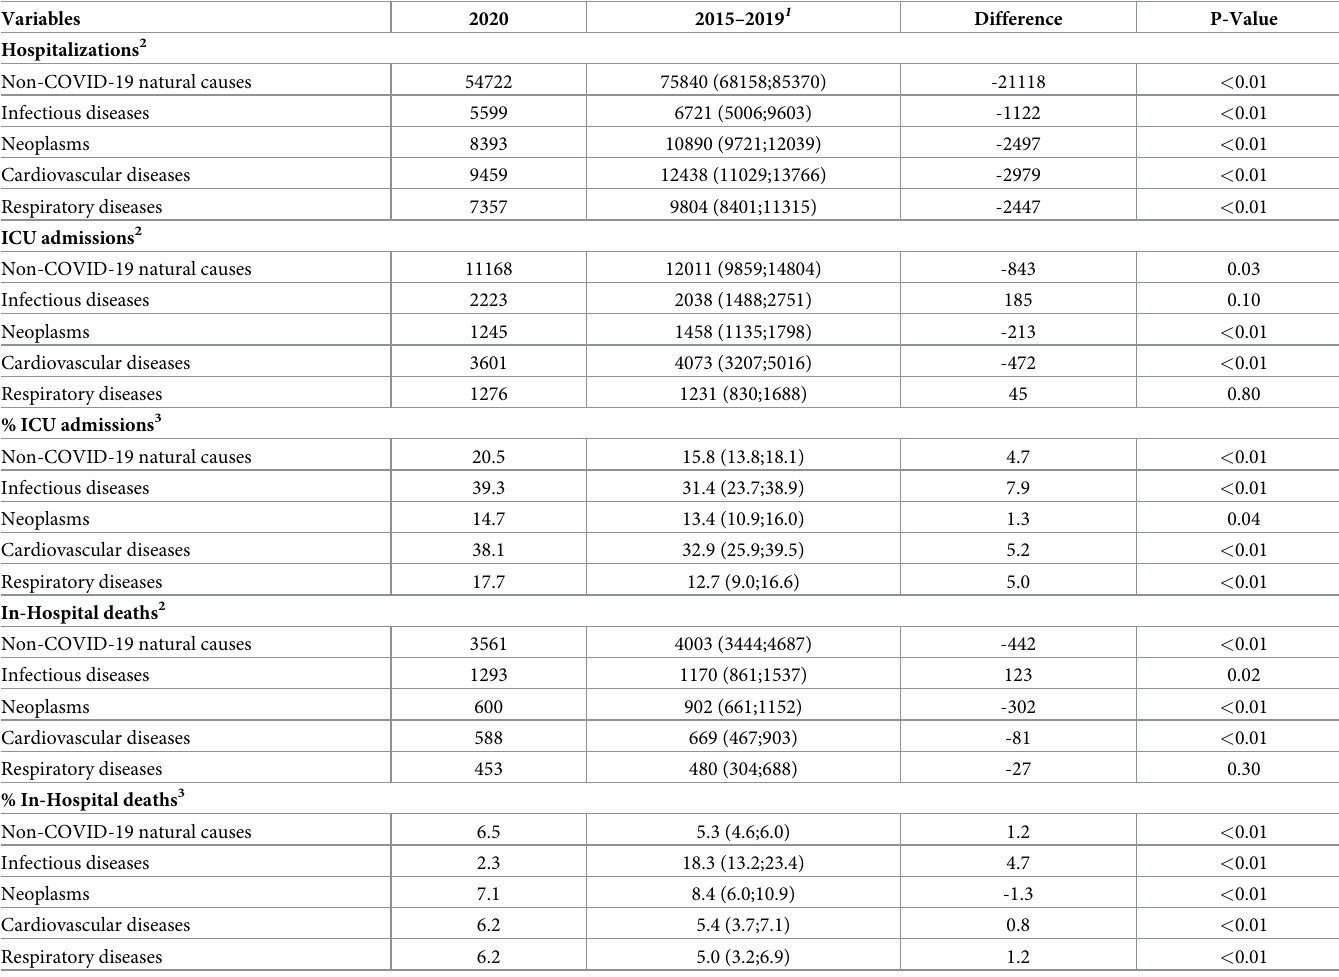
Table 1. Difference in the number of hospitalization, and number and proportion of intensive care unit admission and in-hospital deaths between from epidemio- logical weeks 9–48, 2020 (observed), and the 2015–2019 mean for the same EW, in Belo Horizonte.